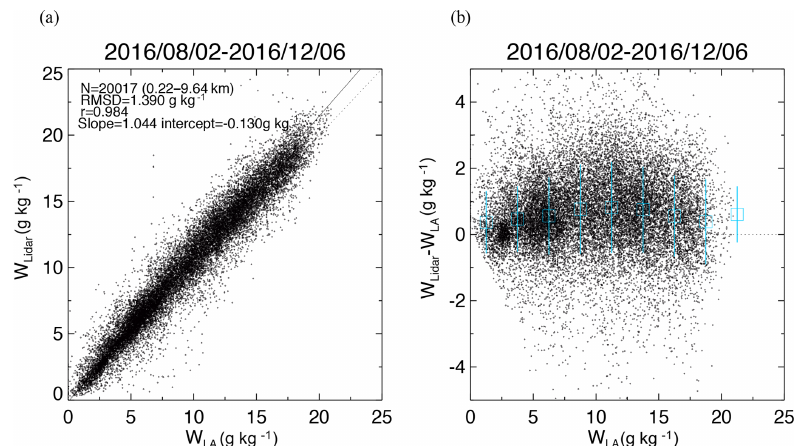
Figure 14. Scatter plots of (a) w obtained with the MRL ( w Lidar ) versus w obtained from the local analysis ( w LA ) and (b) their difference ( w Lidar − w LA ) as a function of w LA from 2 August to 6 December 2016. In (b) , the blue open squares and vertical lines show means and standard deviations of the difference at intervals of 2.5gkg − 1 .